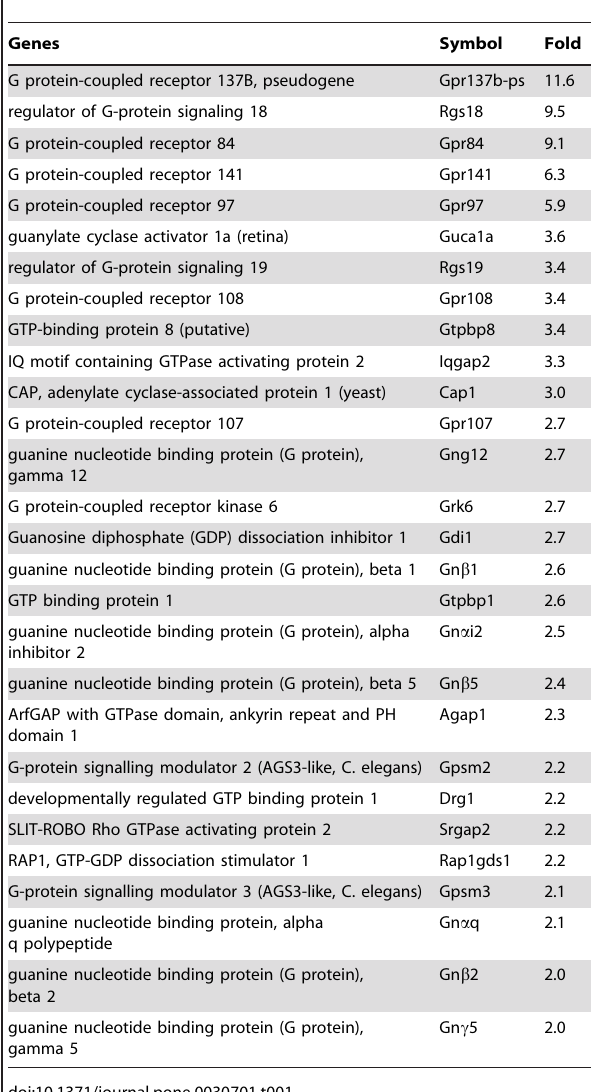
Table 1. Increases of large G-protein superfamily in lal 2 / 2 bone marrow MDSCs.